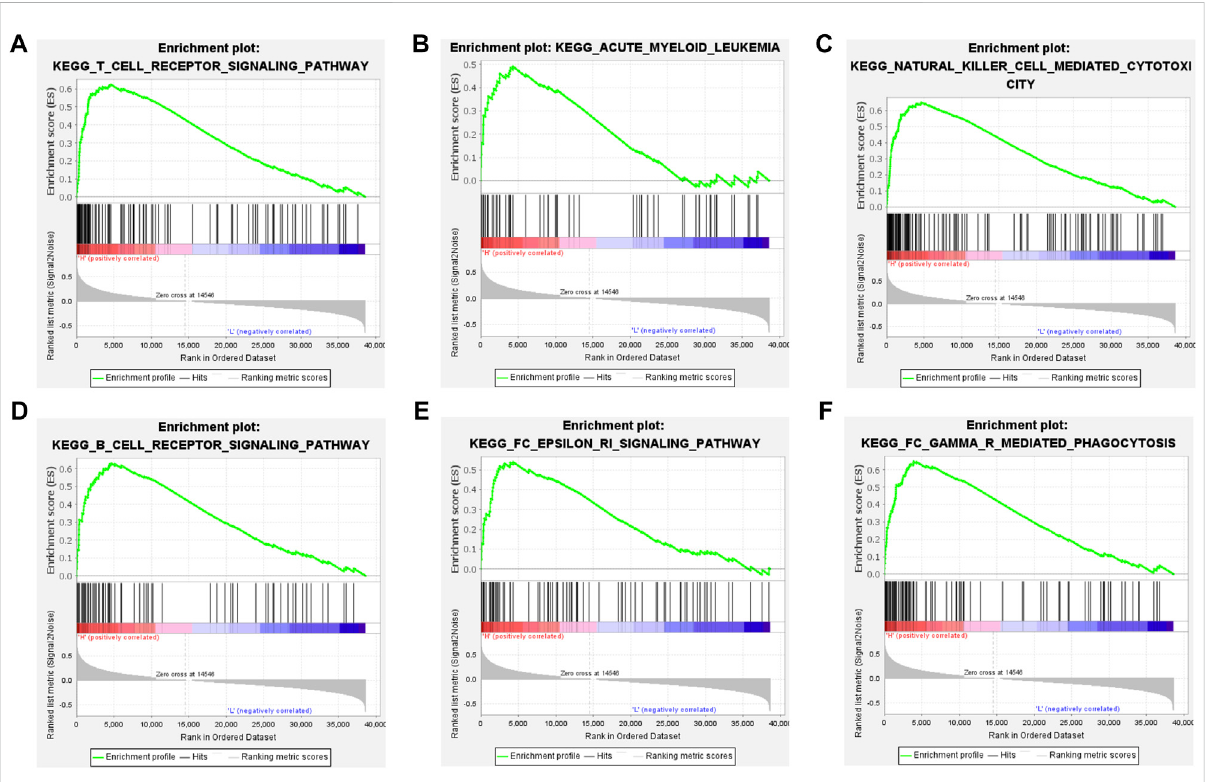
FIGURE 3 GSEA between the high and low immune groups. (A) T cell receptor signaling pathway. (B) Acute myeloid leukemia pathway. (C) Natural killer cell mediated cytotoxicity pathway. (D) B cell receptor signaling pathway. (E) FC epsilon ri signaling pathway. (F) FC gamma r mediated phagocytosis